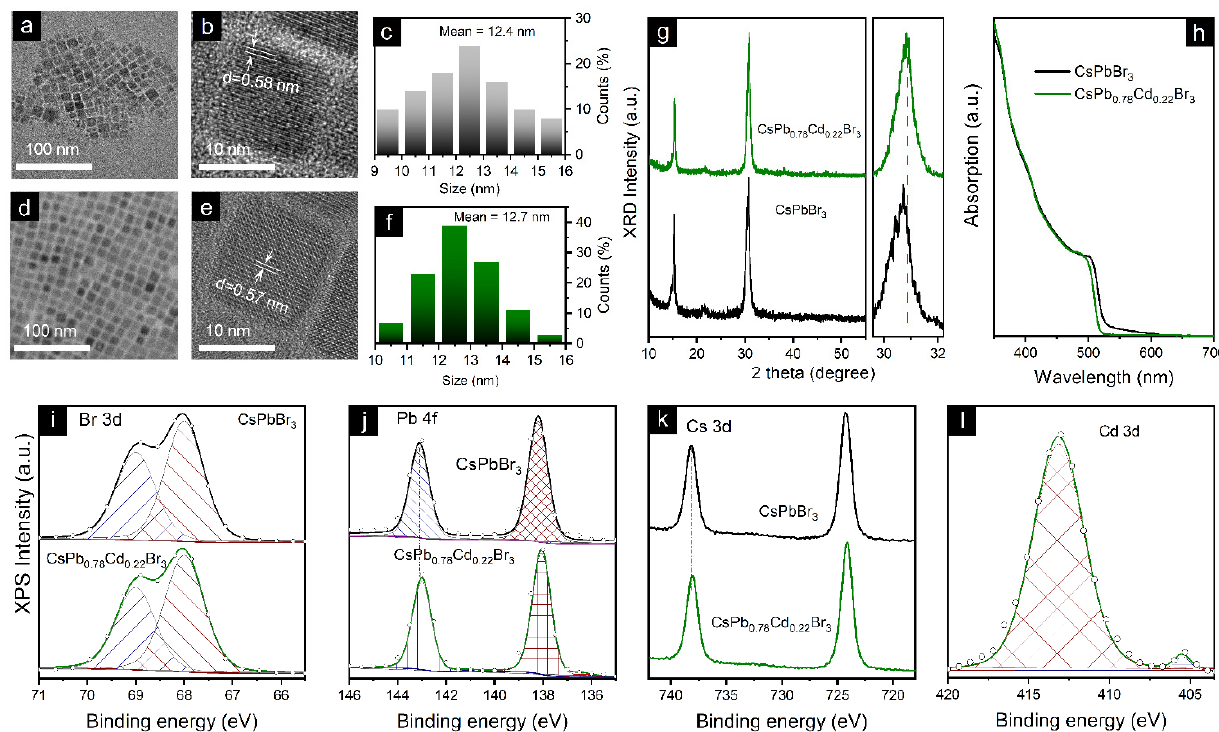
Figure 1. TEM images of ( a ) CsPbBr 3 and ( d ) CsPb 0.78 Cd 0.22 Br 3 NCs; their corresponding HR-TEM images are exhibited in ( b , e ). ( c , f ) are particle size distribution histograms of CsPbBr 3 and CsPb 0.78 Cd 0.22 Br 3 NCs; their corresponding XRD patterns and UV − vis absorption spectra are shown in ( g , h ), respectively. ( i – l ) XPS spectra for the ( a ) Br, ( b ) Pb, ( c ) Cs, and ( d ) Cd elements collected for the CsPbBr 3 and CsPb 0.78 Cd 0.22 Br 3 NCs.